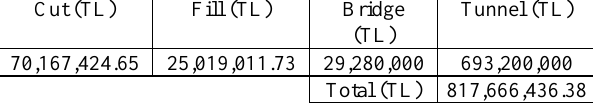
Table 19. Approximate total cost of improving the conventional line on mountainous land